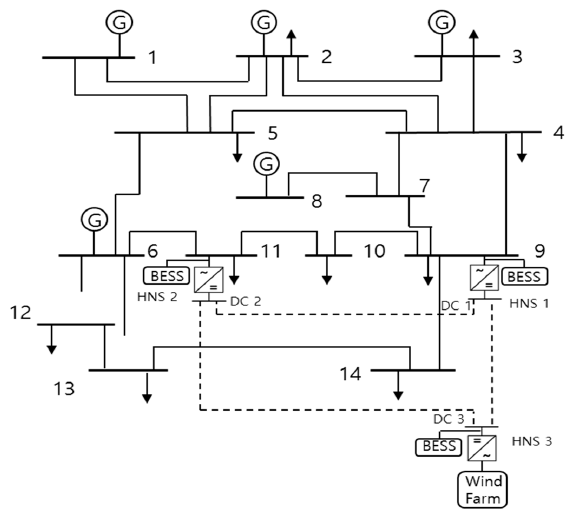
Figure 4. Modified IEEE-14 bus system.